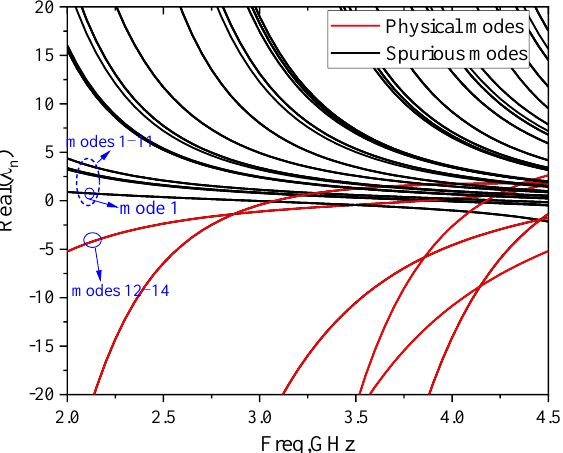
Figure 2. The real parts of characteristic eigenvalues of the first 150 lower order modes in the frequency range from 2.0 GHz to 4.5 GHz.